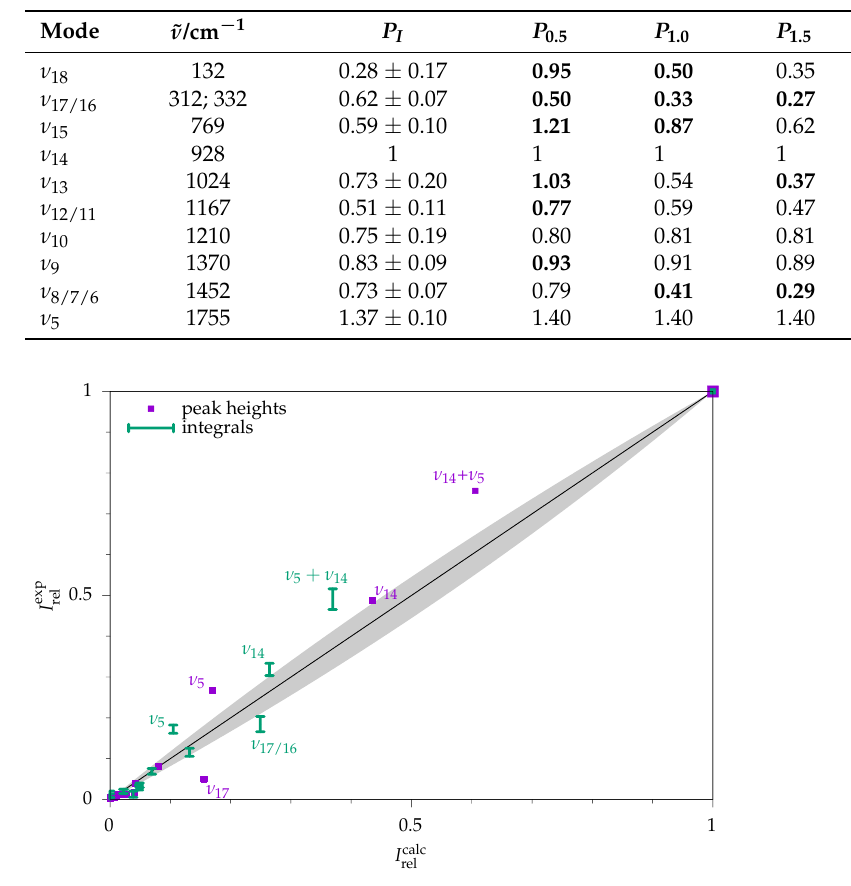
Figure 8. Ratio of calculated and experimental intensities for methyl methanoate. Violet points: peak height method ( σ = 1.0cm − 1 ). Green error bars: integral method; both normalised to give 1 in sum. Selected strong fundamentals and sums of fundamentals are labeled to exemplify that the deviations between experiment and theory are often correlated among the two methods. The area that would be covered by an anharmonicity effect of up to 20% is shaded in grey.